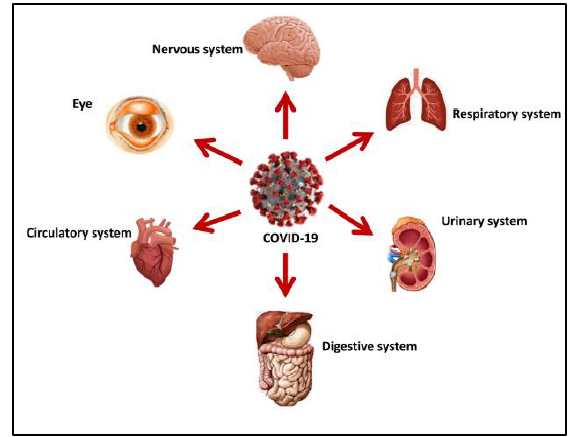
Figure 4. Schematic figure displaying